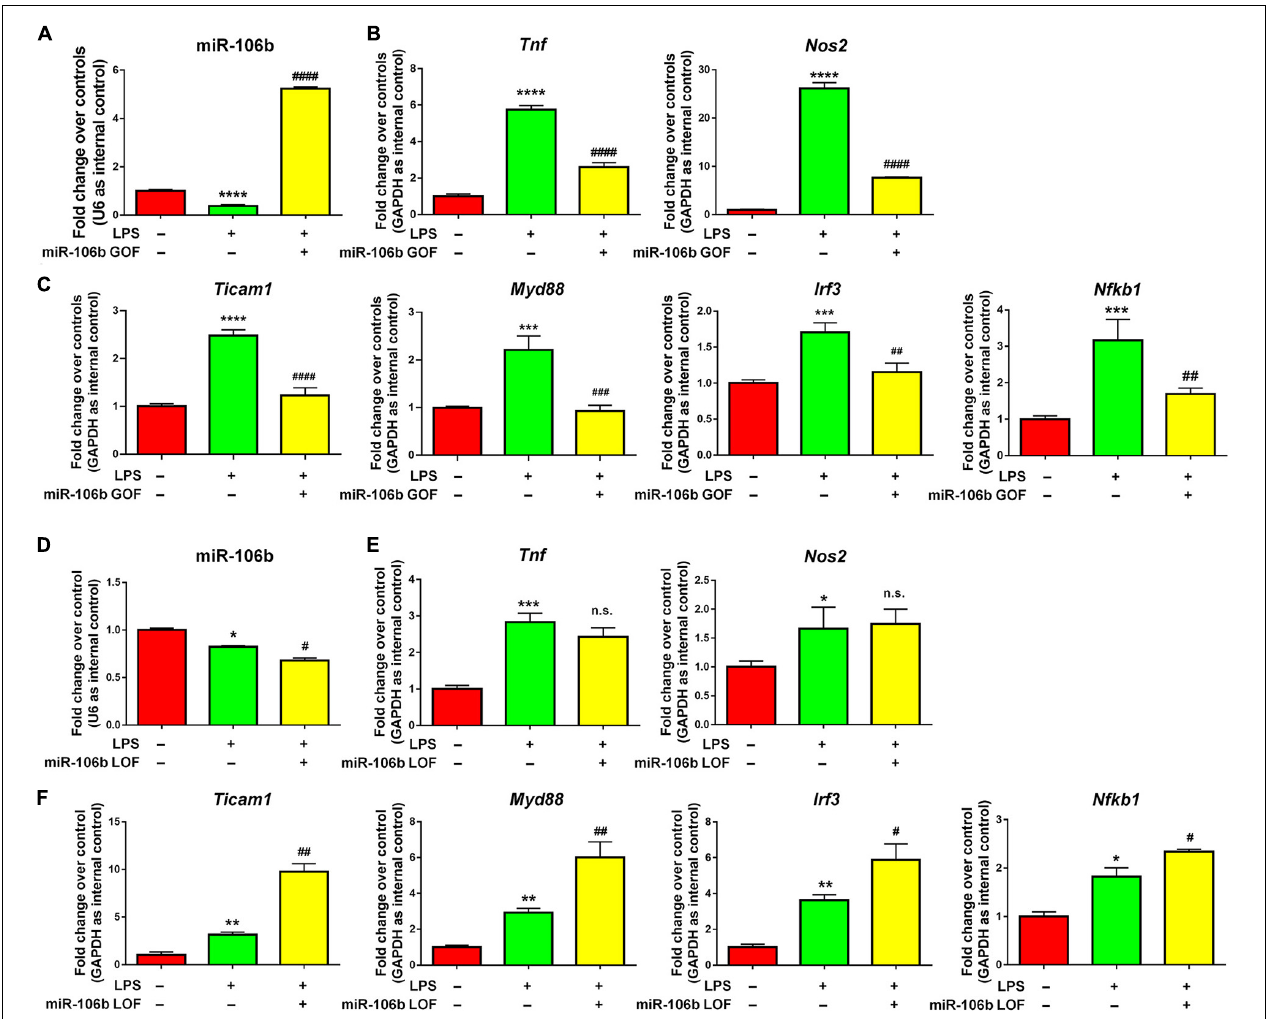
FIGURE 4 | miR-106b suppresses LPS-stimulated microglia. (A) Primary mouse microglia were stimulated by LPS, followed by the transfection of miR-106b mimics and mimics control for 2 days. miR-106b GOF in microglia was validated by qRT-PCR. (B) The transcript levels of pro-inflammatory genes Tnf and Nos2 in microglia were determined by qRT-PCR. (C) The transcript levels of NF- κ B signaling component genes Ticam1 , Myd88 , Irf3 , and Nfkb1 in microglia were determined by qRT-PCR. (D) Primary mouse microglia were stimulated by LPS, followed by the transfection of miR-106b mimics and mimics control for 2 days. miR-106b LOF in microglia was validated by qRT-PCR. (E) The transcript levels of pro-inflammatory genes Tnf and Nos2 in microglia were determined by qRT-PCR. (F) The transcript levels of NF- κ B signaling component genes Ticam1 , Myd88 , Irf3 , and Nfkb1 in microglia were determined by qRT-PCR. Data were represented as mean ± SD from three independent experiments. The symbols *, **, *** and **** denote p < 0.05, p < 0.01, p < 0.001 and p < 0.0001, respectively, in comparison with control group. The symbols # , ## , ### , and #### denote p < 0.05, p < 0.01, p < 0.001, and p < 0.0001, respectively, in comparison with LPS group. n.s. denotes